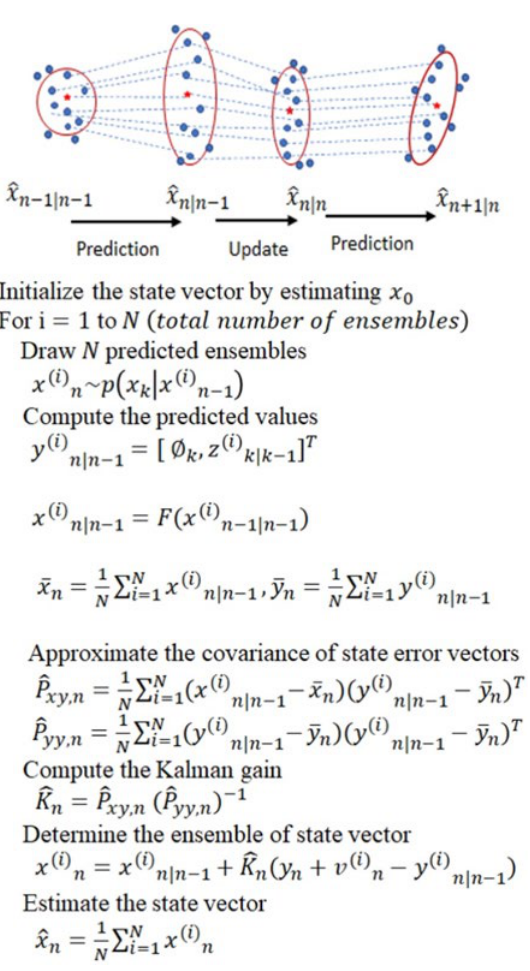
Figure 1. An overview of EnKF. EnKF maintains an ensemble of sample points for the state vector x n . It propagates and updates the ensemble to track the distribution of x n . The state estimation is conducted by calculating the sample mean (red five-pointed-star) and covariance (red ellipse) of the ensemble.